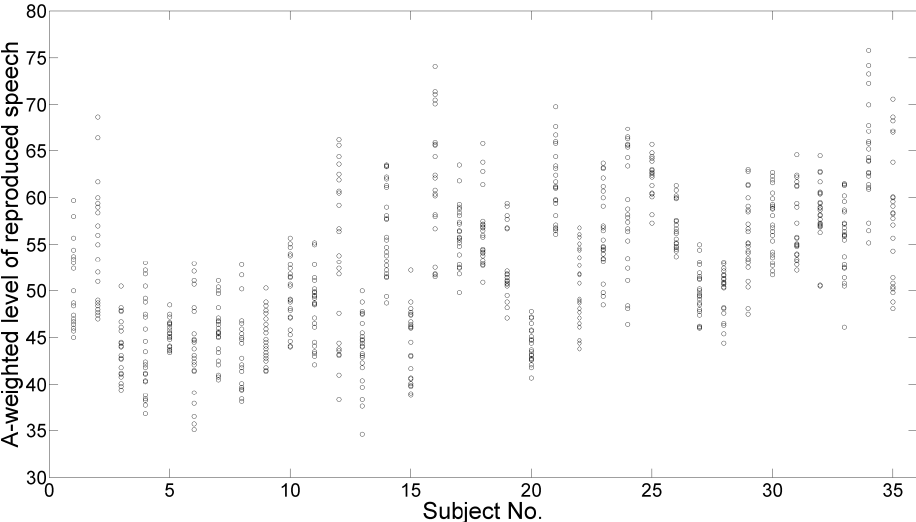
Figure 3. The range of observations provided by each subject for the A-weighted level of speech in the listening part of the experiment.